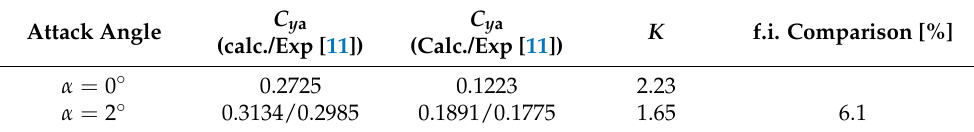
Table 3. Aerodynamic coefficients for the